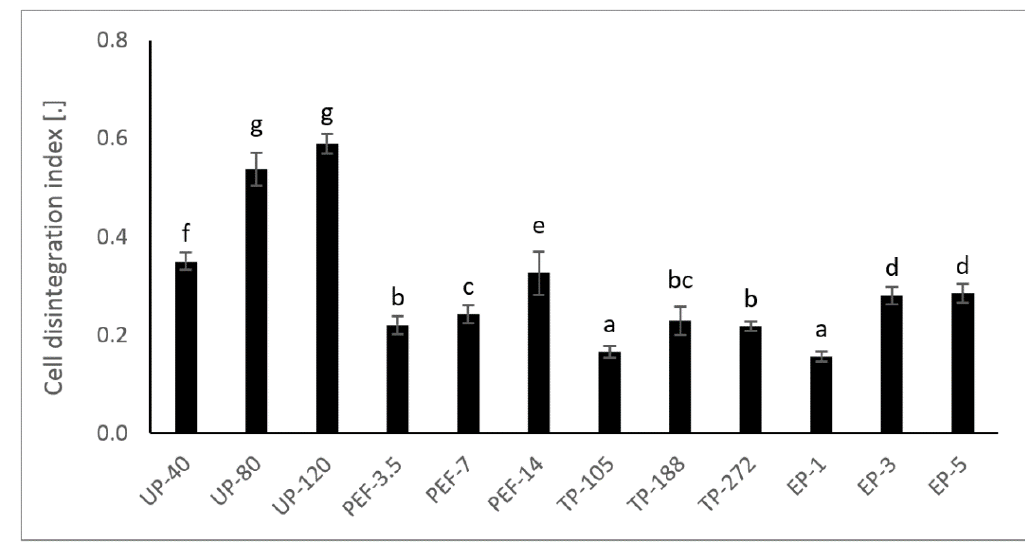
Figure 1. Influence of pretreatment on cell disintegration index (Zp) of fresh turmeric. Means with different lowercase letters indicate significant differences ( p < 0.05). Ultrasound pretreatment (UP), Pulsed electric field pretreatment (PEF), Thermal pretreatment (TP), Enzyme pretreatment (EP).